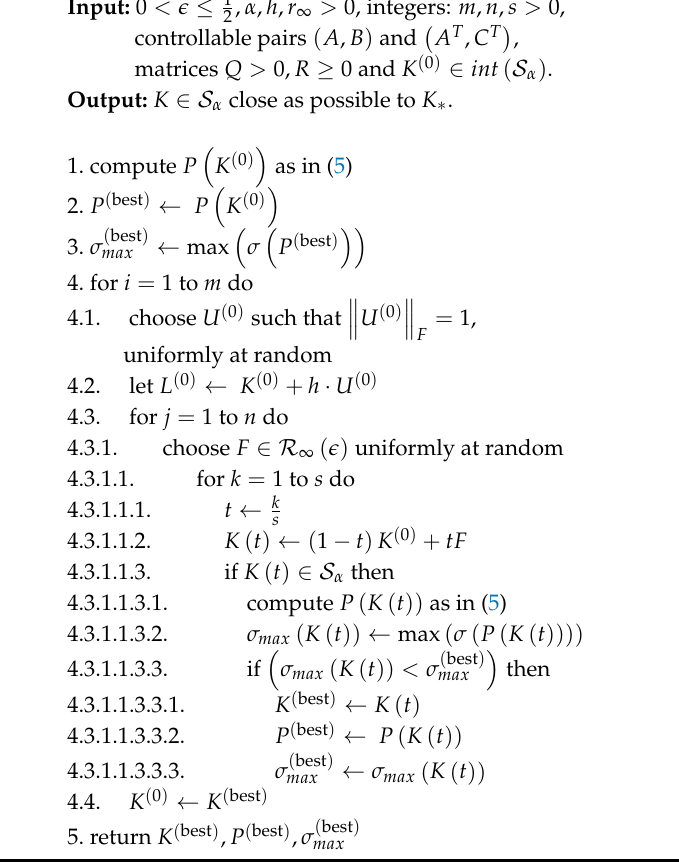
Algorithm 1: The practical randomized algorithm for the LQR via static-output-feedback (SOF)